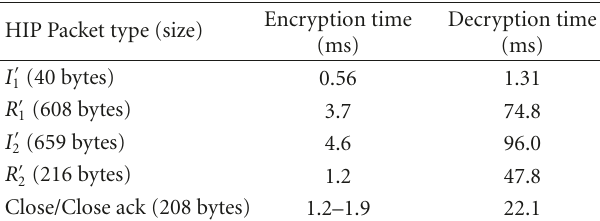
Table 3: Encryption and decryption times for the di ff erent HOP packet types.